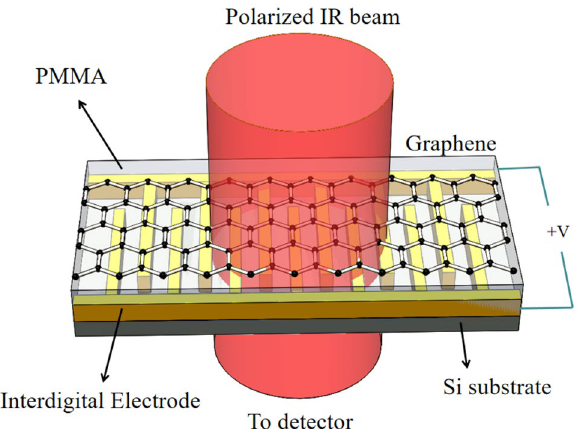
Figure 1. The 3D schematic of the modulator, the movement and density of carrier are controlled by the voltage applied on the interdigital electrode. The energy of excited SPPs will be absorbed in the graphene layer and result in a resonant dip in transmission, which can be collected by the